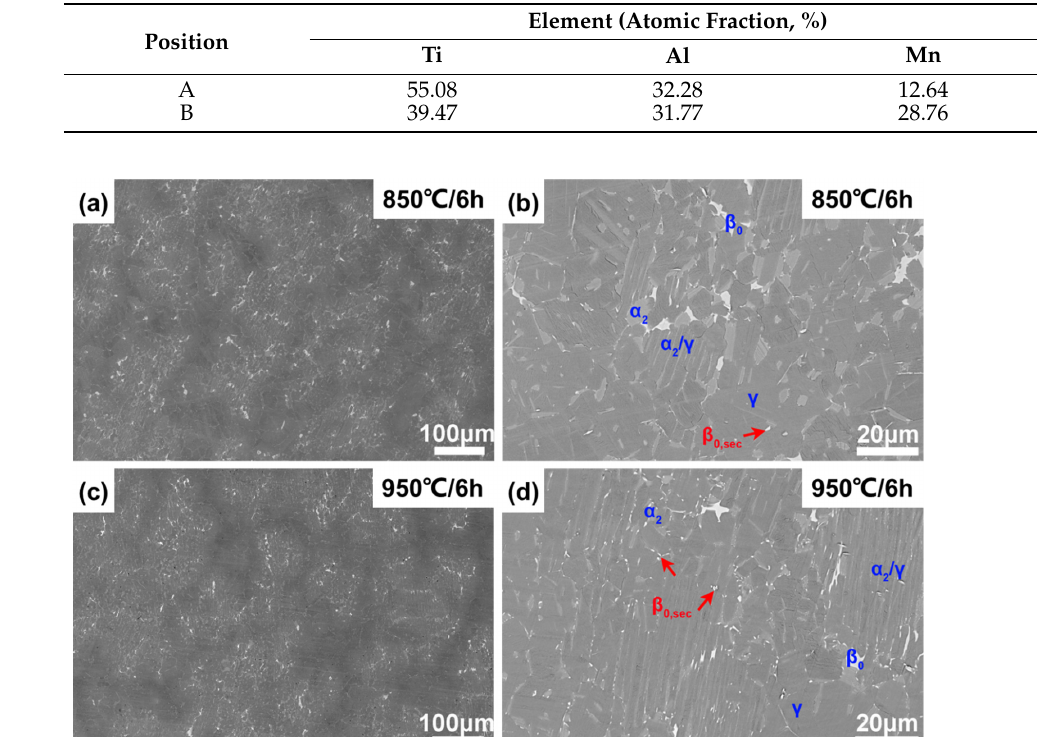
Table 3. Compositions at different positions in Figure 6 identified by EDS.